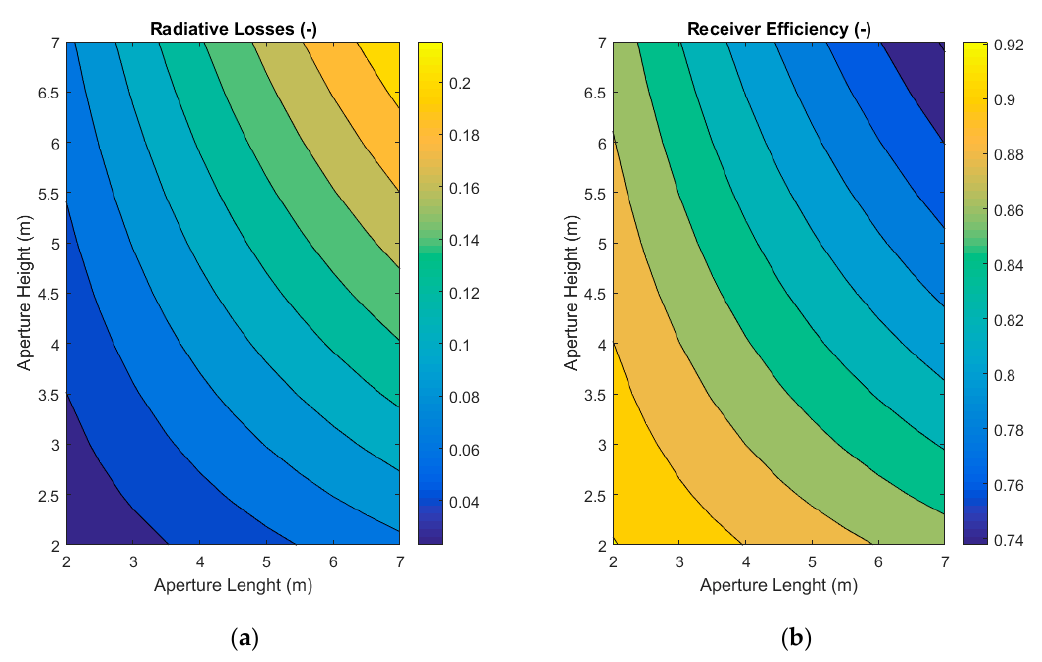
Figure 8. Influence of the aperture dimensions on ( a ) the radiative losses—normalized by the receiver power—and ( b ) on the receiver efficiency, for the following parameters: M = 5 panels, d ape = 7 m, α = 30° and θ = π /2.